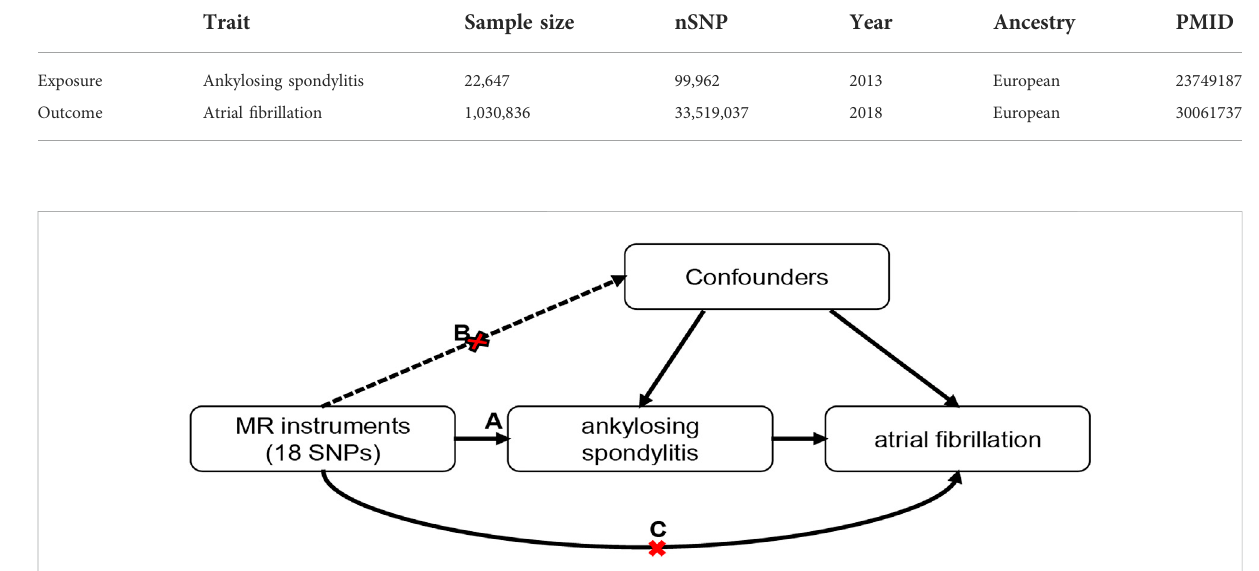
FIGURE 1 Schematic of the Mendelian randomization framework. Three core assumptions were as follows: (A) the SNPs should be strongly associated with ankylosing spondylitis; (B) the SNPs should not be related to confounders; (C) the SNPs should not be directly associated with atrial fi